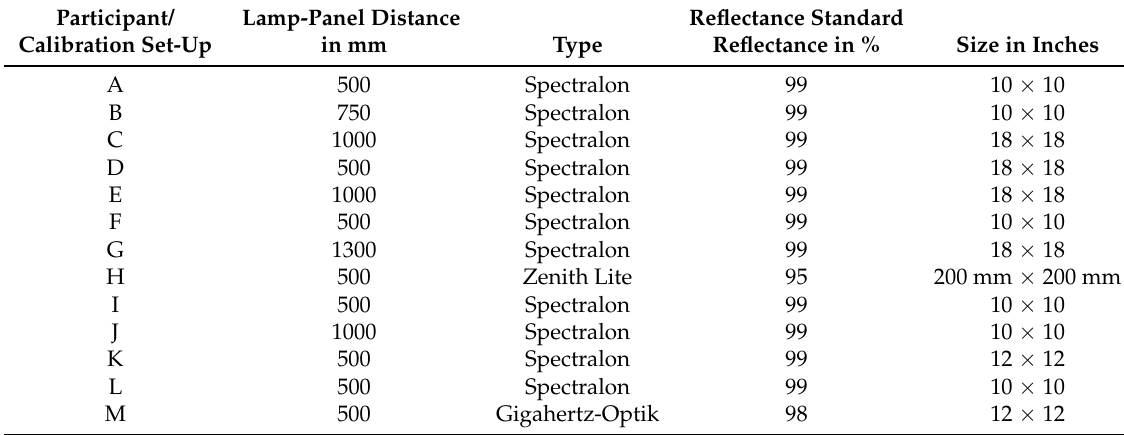
Table 2. Detailed information about each participant (A through M) lamp-panel distance setting and type and size of the reflectance